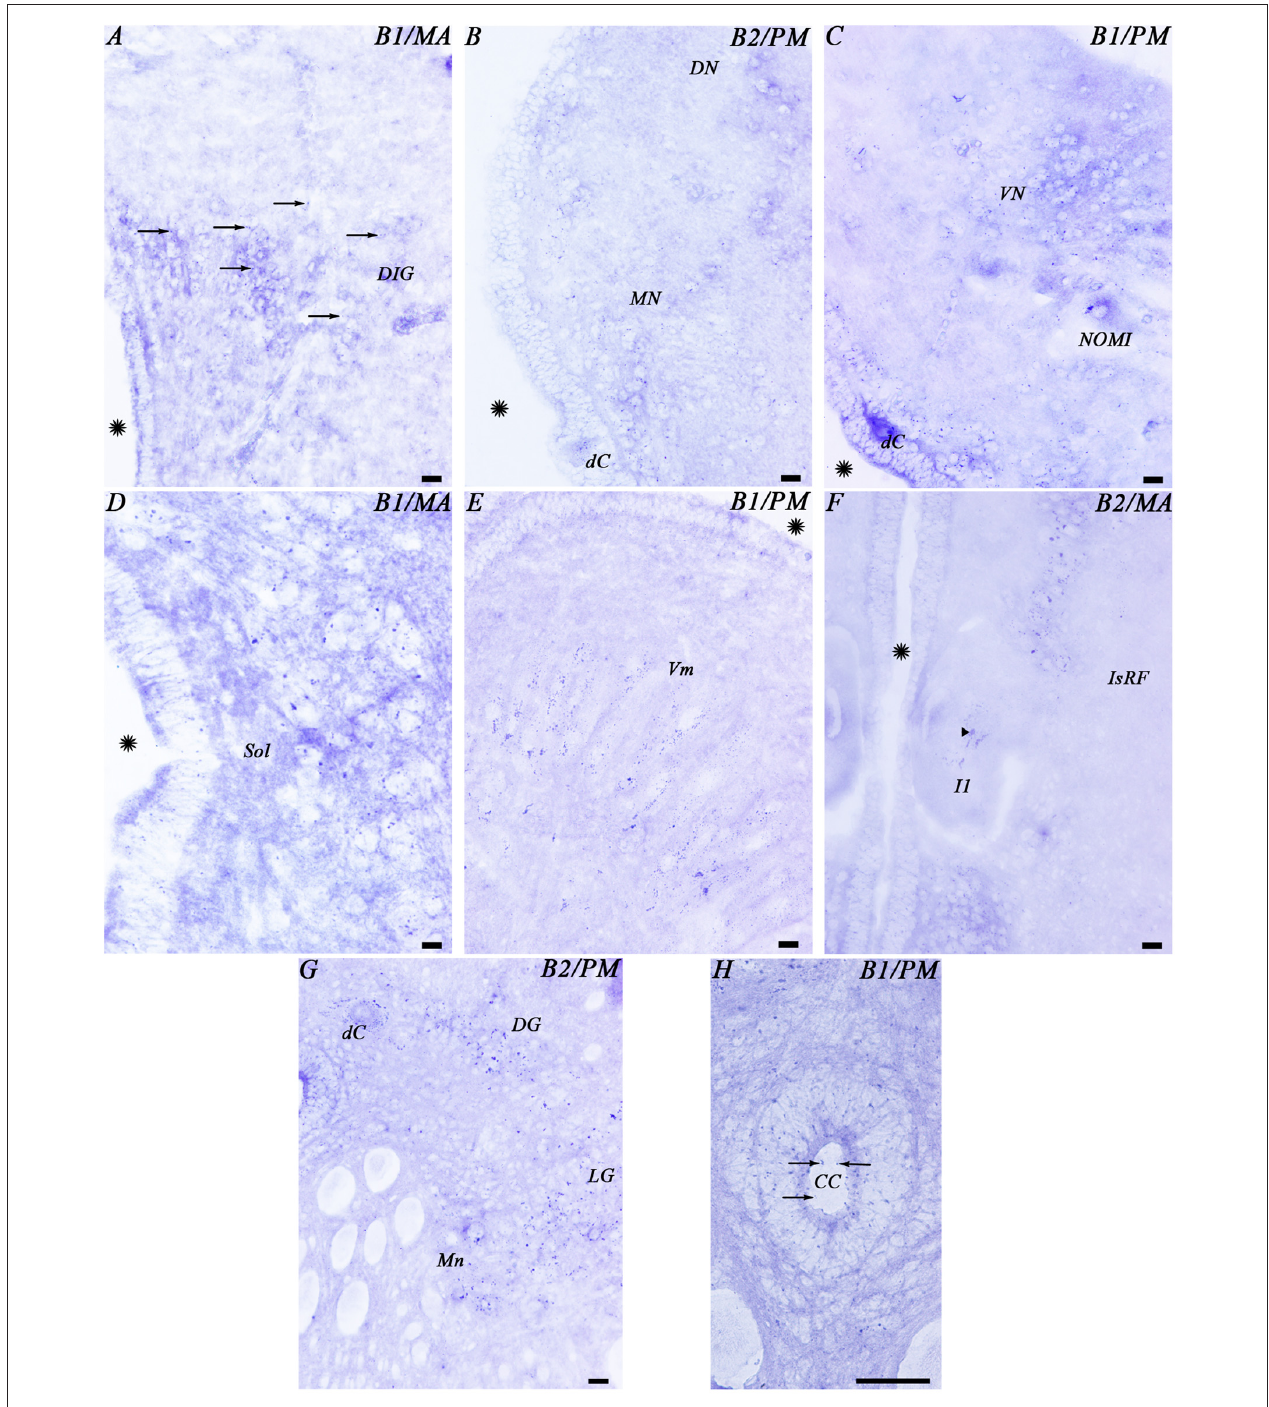
FIGURE 6 | Photomicrographs from different regions of the mesencephalon (A,B) , rhombencephalon (C–F) and spinal cord (G,H) showing expression of both GABA B transcripts. Abbreviations as in Figure 4 . Arrows indicate small positive dots. The arrowhead indicates accumulations of transcript expression in a giant cell. Asterisks indicate the ventricle. Scale bars = 50 µ m.